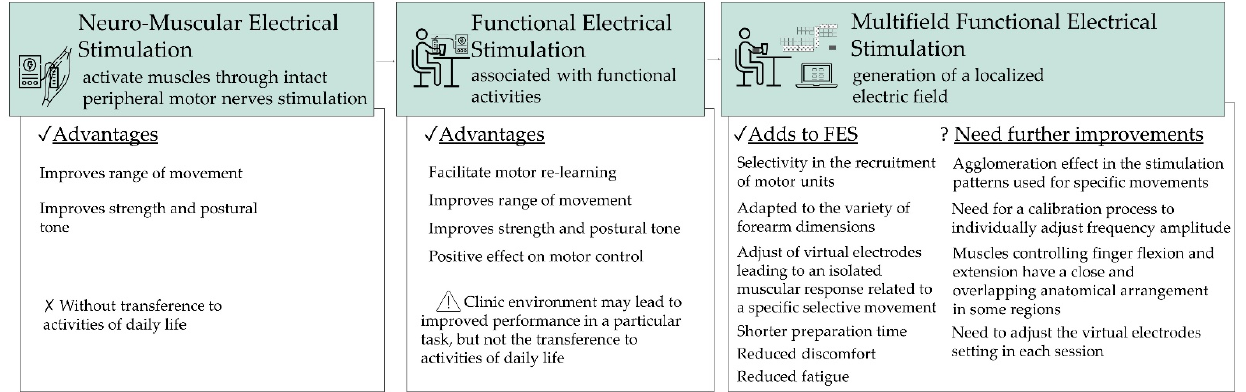
Figure 2. Advantages of NMES and FES-based